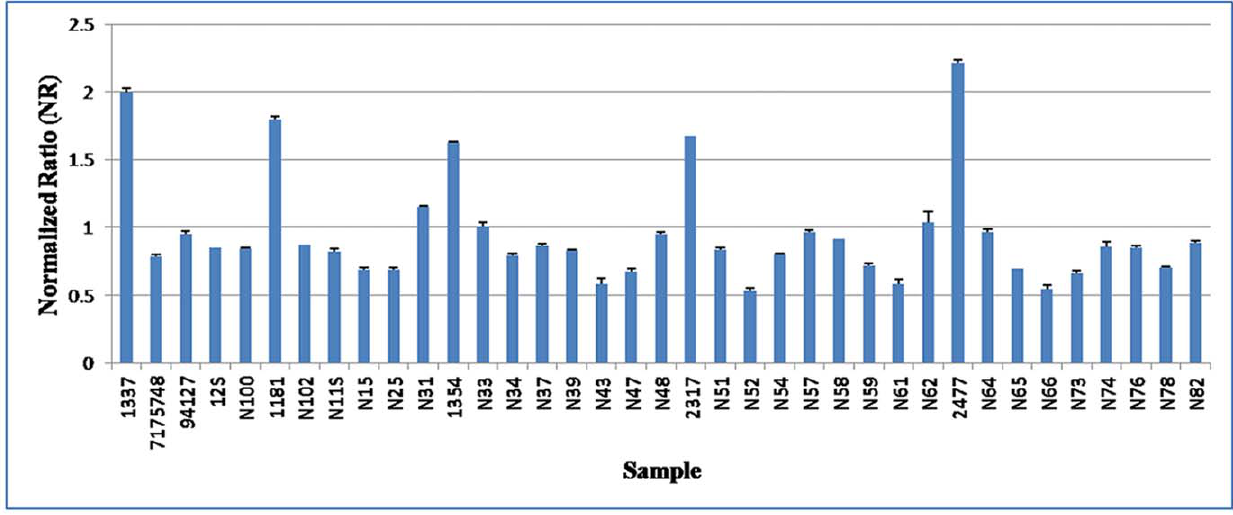
Figure 3. Results of qPCR validation for one CNVR (No. 43). NR around 2 indicates normal status (no CNV) and NR around 1 indicates one copy loss. The error bars represent the standard error among three technical